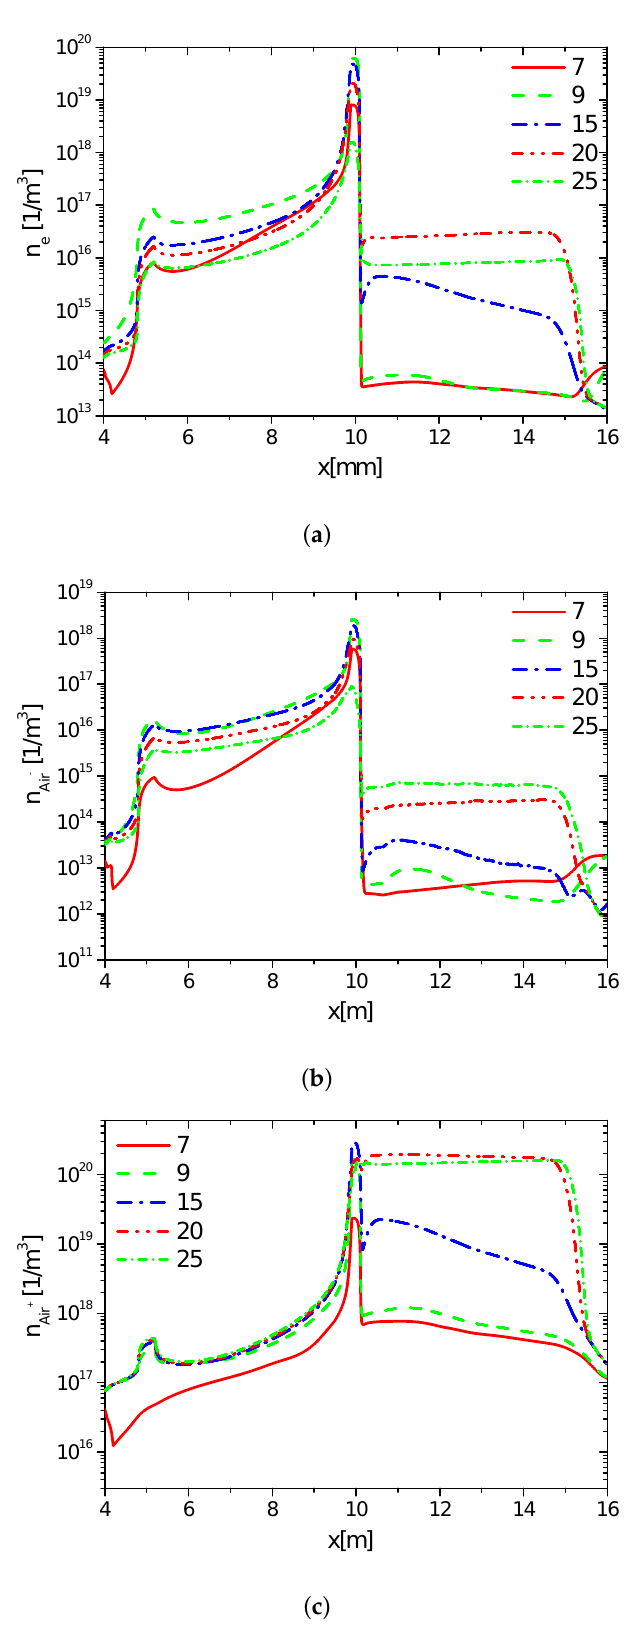
Figure 4. The distributions of the densities of electrons ( n e ), negative ions ( n Air − ) and positive ions ( n Air + ) on the wall surface at time 7 ns, 9 ns, 15 ns, 20 ns, and 25 ns in the rise phase in Case